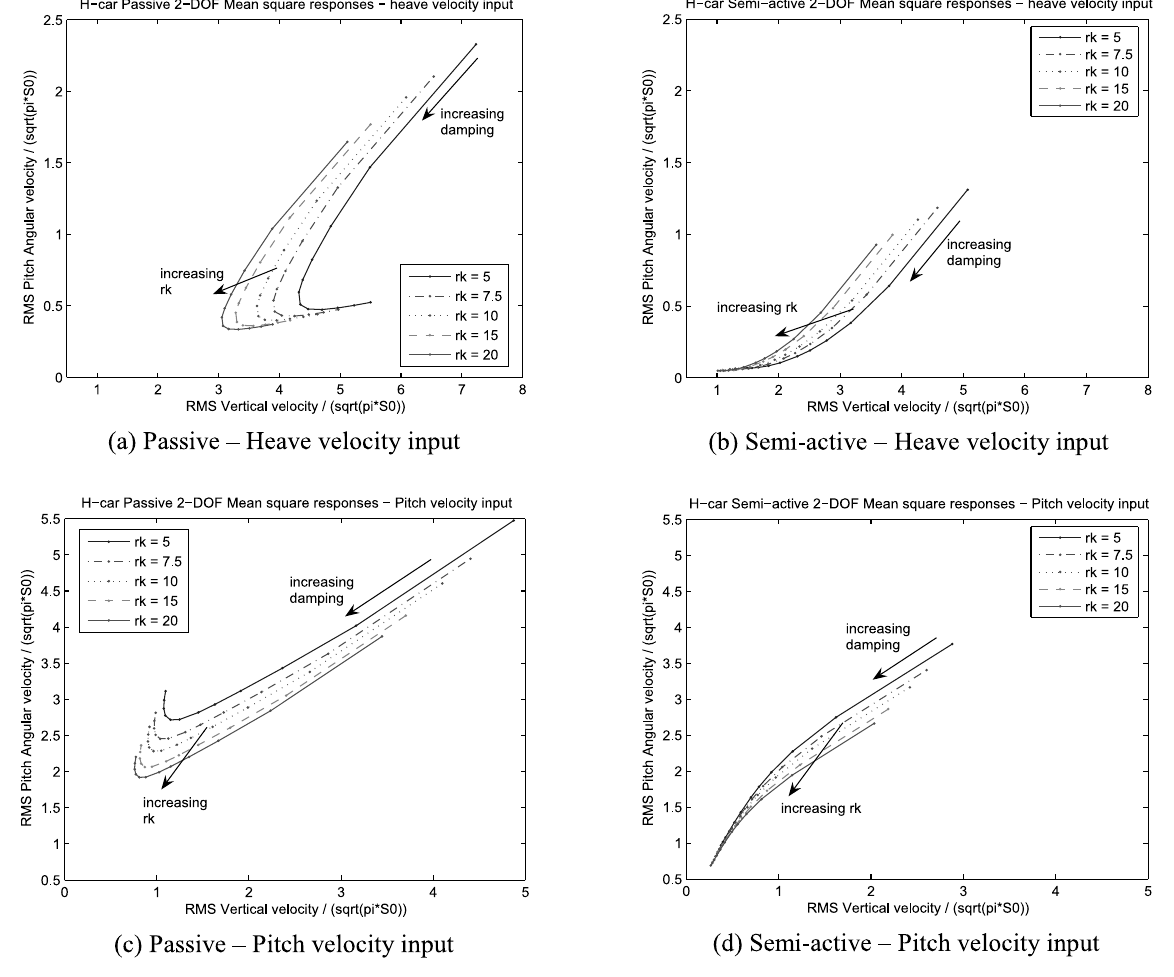
Fig. 7. Relationship between the rms pitch angular velocity to rms vertical